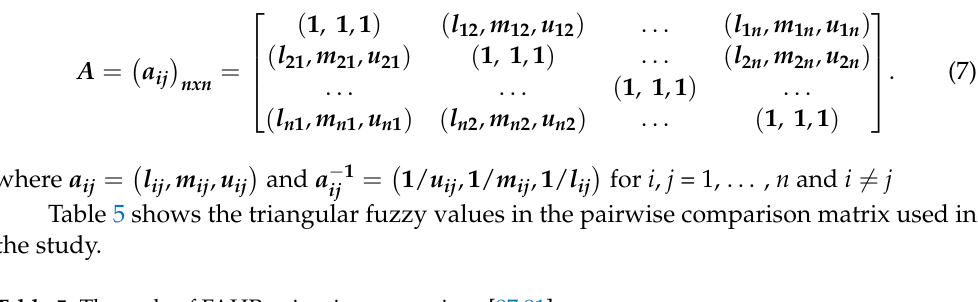
Table 5. The scale of FAHP pair-wise comparison [87,91]. Linguistic